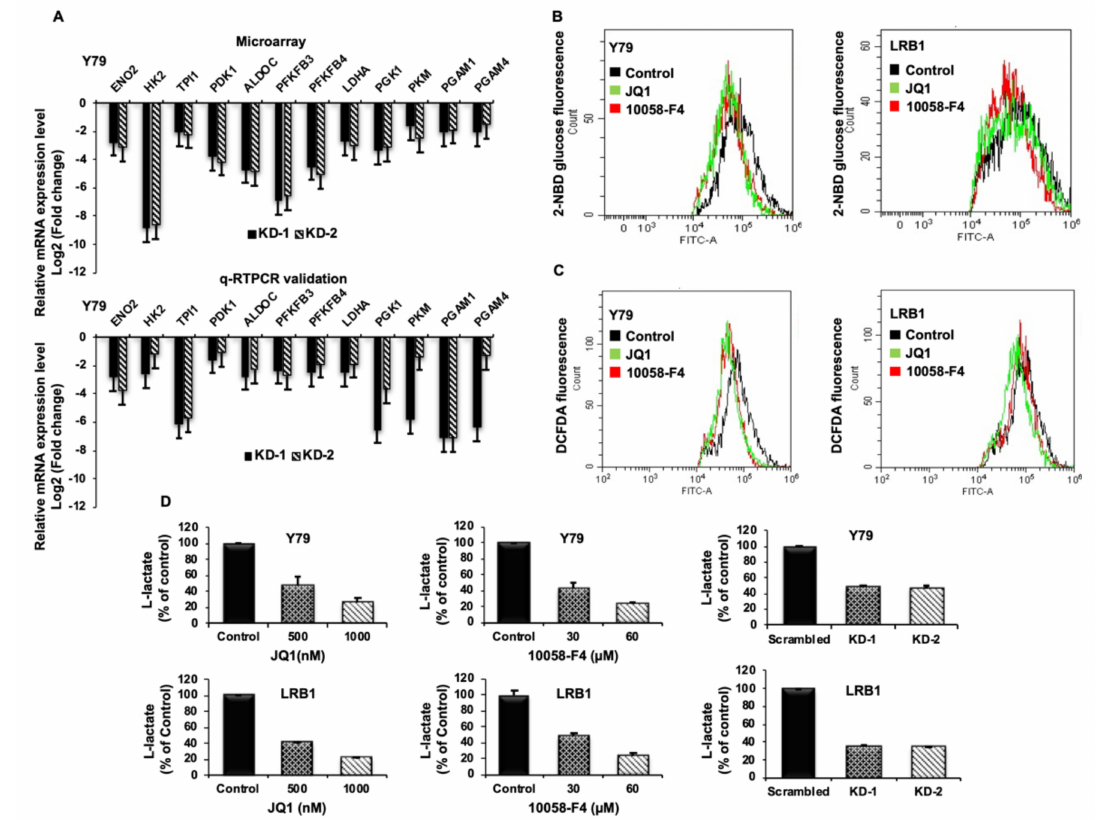
Figure 6. The impact of MYCN inhibition on metabolic parameters in RB cells. ( A ) Top 12 downregulated differentially expressed metabolic genes identified by microarray data analysis (upper panel) and qRT-PCR validation of the identified DEGs (lower panel). ( B , C ) Decreased levels of glucose uptake and reactive oxygen species (ROS) were observed upon MYCN inhibition compared to the untreated control cells. ( D ) MYCN inhibition with small molecule inhibitors and shRNA knockdown led to decreased lactate levels in Y79 and LRB1 cells. The error bars represent standard error of